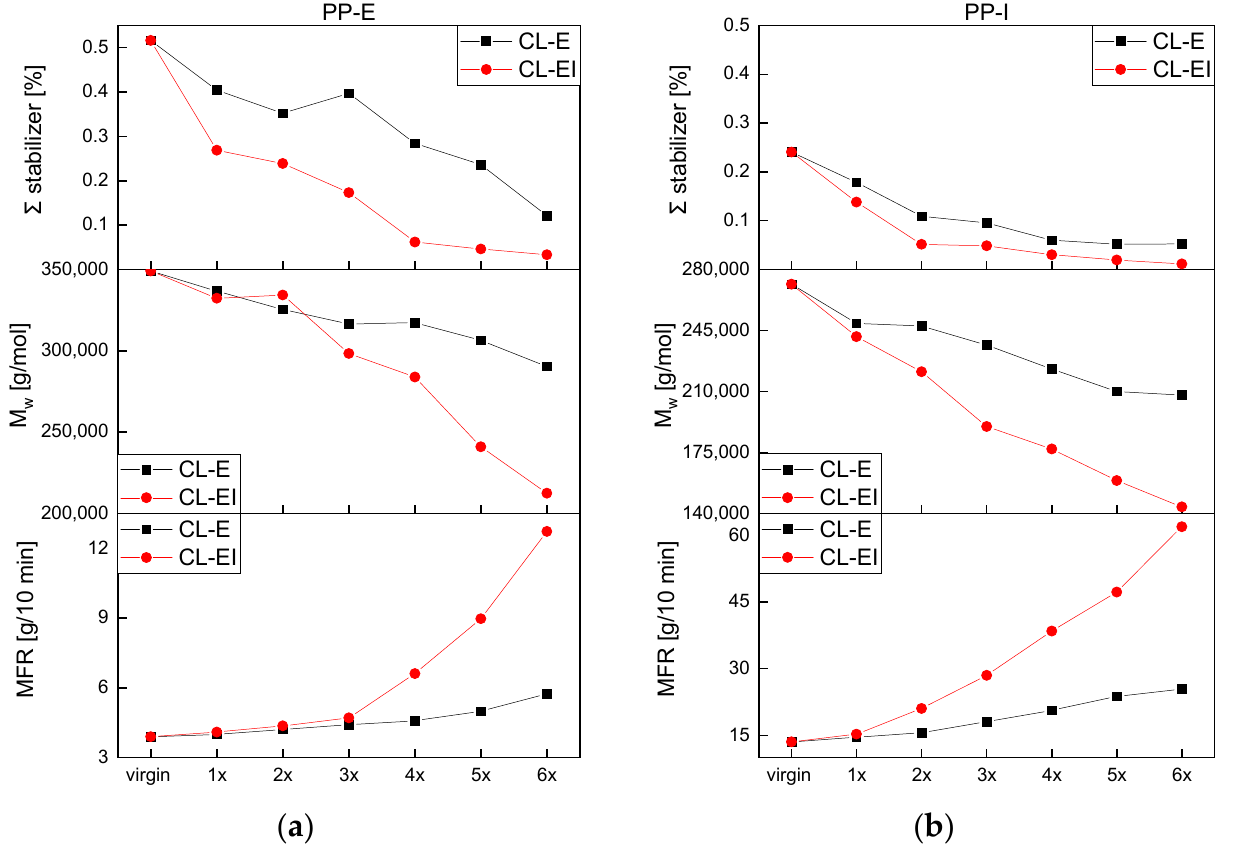
Figure 11. The sum of antioxidants (IF168 and IX1010), the weight average molar mass (M w ), and the melt flow rate (MFR) as a function of recycling steps for ( a ) PP-E, and ( b ) PP-I.